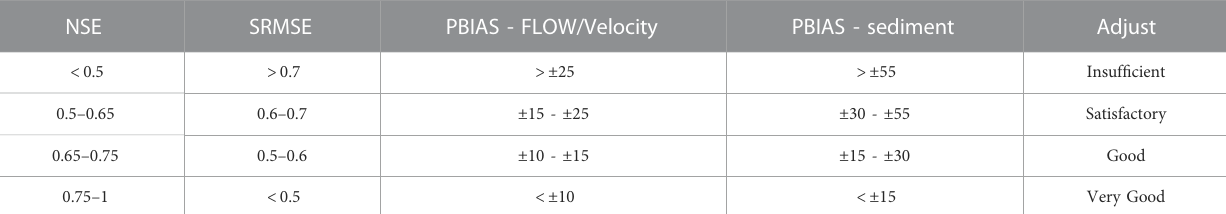
TABLE 7 Statistics indices for